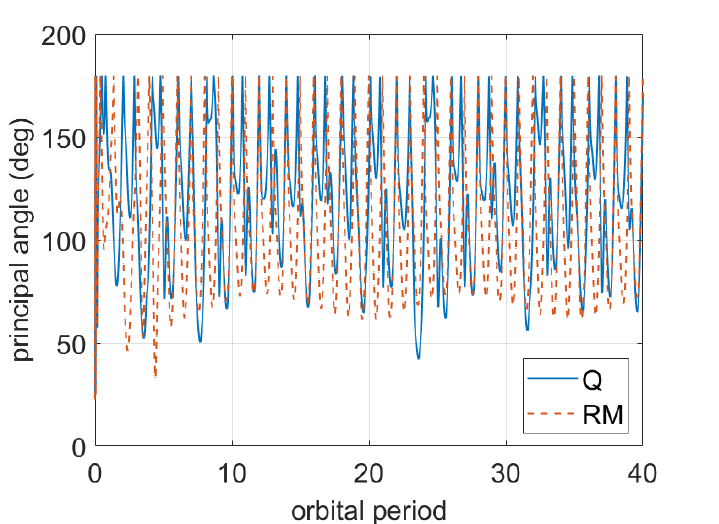
Figure A2. Time histories of principal angle using quaternion feedback (Q, blue solid line) and using rotation matrix feedback (RM, red dashed line) obtained in a simulation in perturbed conditions without compensation of the residual magnetic